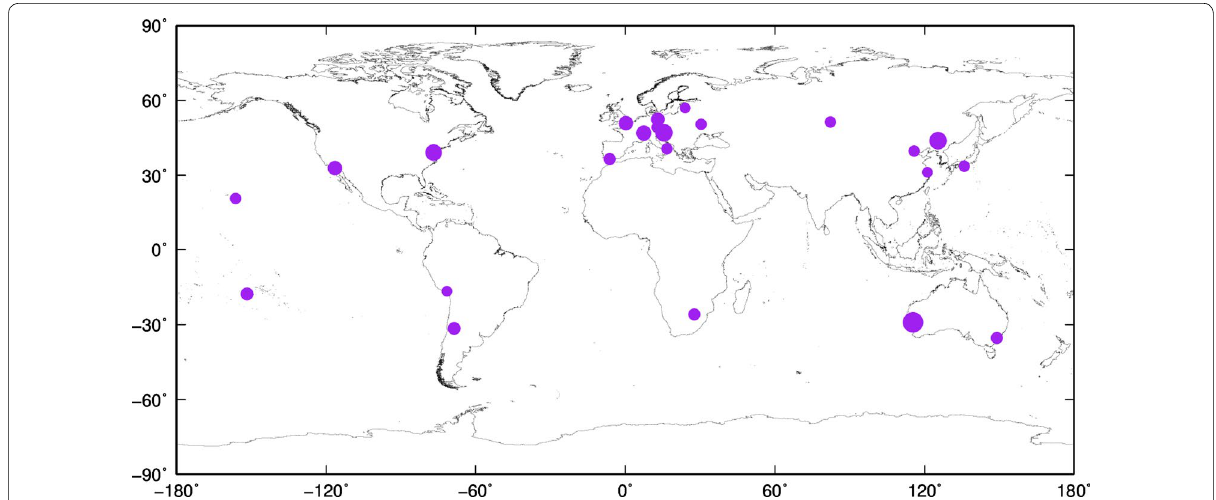
Fig. 3 Ground distribution of SLR sites. Only the GRACE-A satellite was tracked (the number of SLR NPs is consistent with the size of